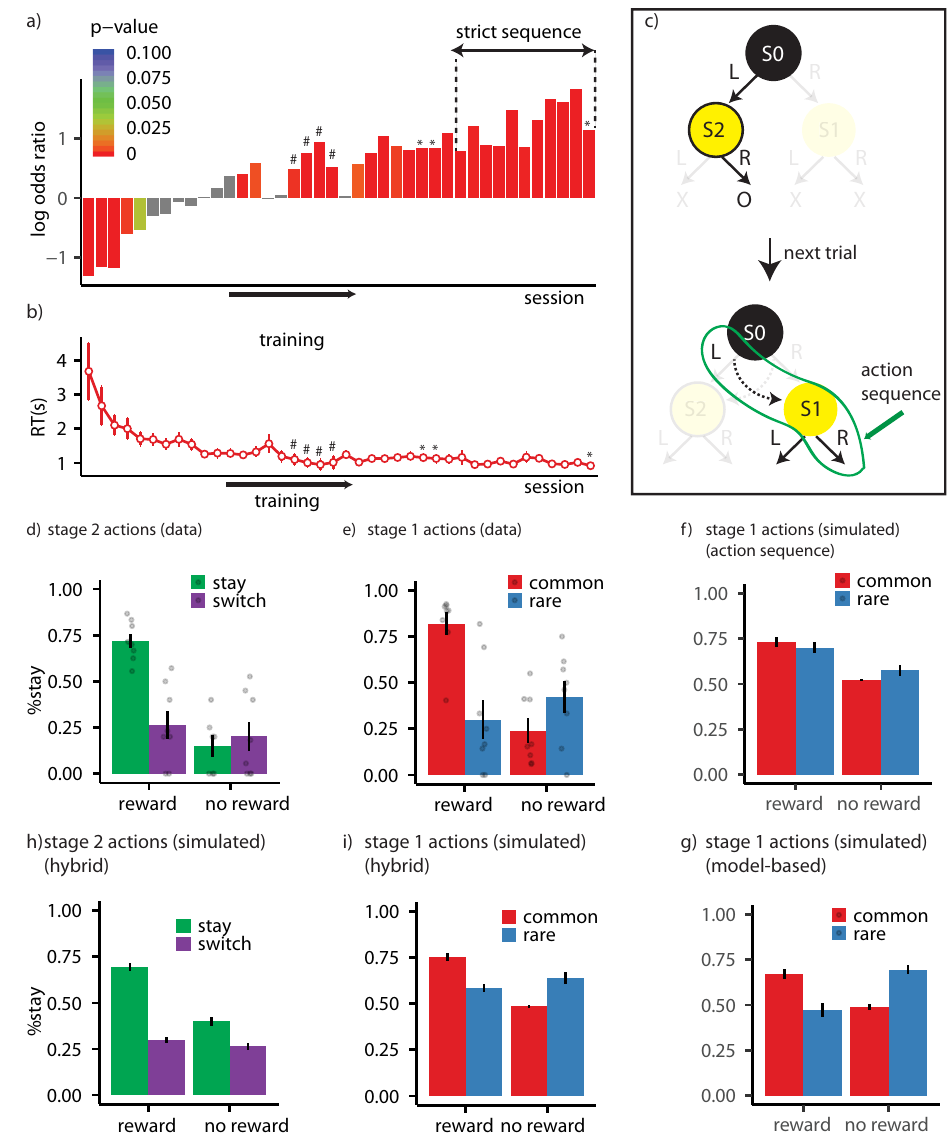
Fig 3. (a) Logarithm of odds ratio of staying on the same stage 1 action after getting rewarded on the previous trial over the odds ratio after not getting rewarded. The zero point on the y -axis represents the indifference point (equal probability of staying on the same stage 1 action after reward or no reward). Each bar represents the odds ratio for a single training session. In the sessions marked with ‘#’ in Figure 3a the contingency between stage 1 actions and stage 2 states were revered (‘L’ leads to S1 and ‘R’ to S2). ‘Strict sequence’ refers to sessions in which a trial was aborted if the animal entered the magazine between stage 1 and stage 2 actions. Sessions marked with ‘ � ’ are probe sessions in which the task involved both rare and common transitions. (b) Reaction times (RT) averaged over subjects. RT refers to the delay between performing the stage 1 and stage 2 actions. Each dot represents a training session. (c) An example of